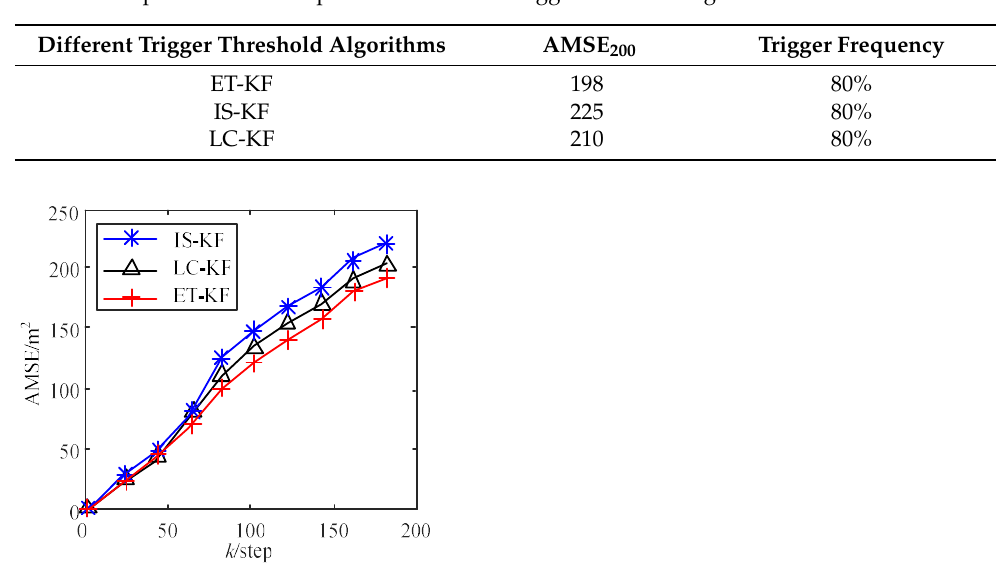
Figure 3. AMSE of ET-KF algorithm and Σ tr P Table 4. The performance comparison of different trigger threshold algorithms.